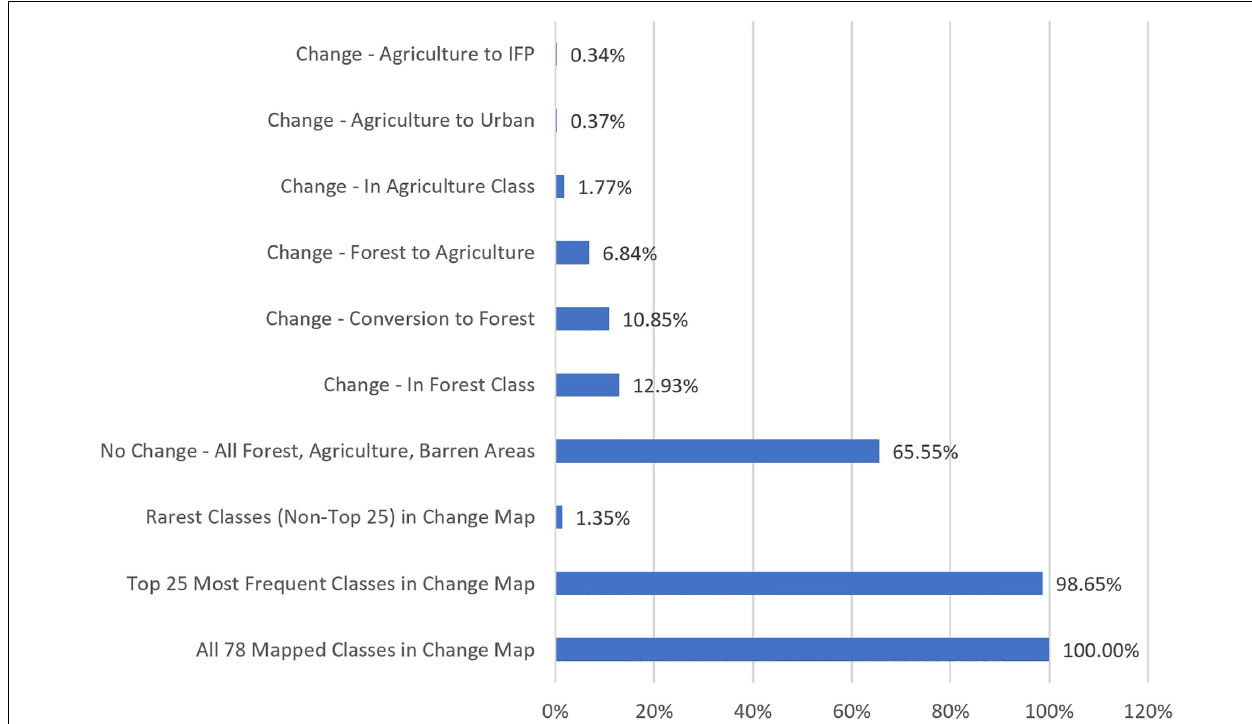
FIGURE 8 | Percent frequency of grouped LULC change categories compared to total mapped area. For this figure: (1) forests pertain to semi-natural deciduous forests, evergreen broadleaved forests, and scrub/shrub/herbaceous areas; (2) agriculture includes permanent crops and shifting cultivation areas; (3) IFP = Industrial Forest Plantations. For additional information, see Supplementary Table S4